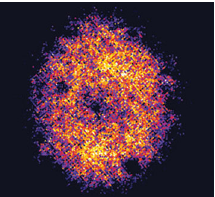
FIG. 8. Observed distribution of 2nd harmonic ICS radiation from a circular polarized laser field, with spectral band isolated using a 250 μ m Al filter. The annular shape of the radiation distribution implies existence of a strong transverse helical